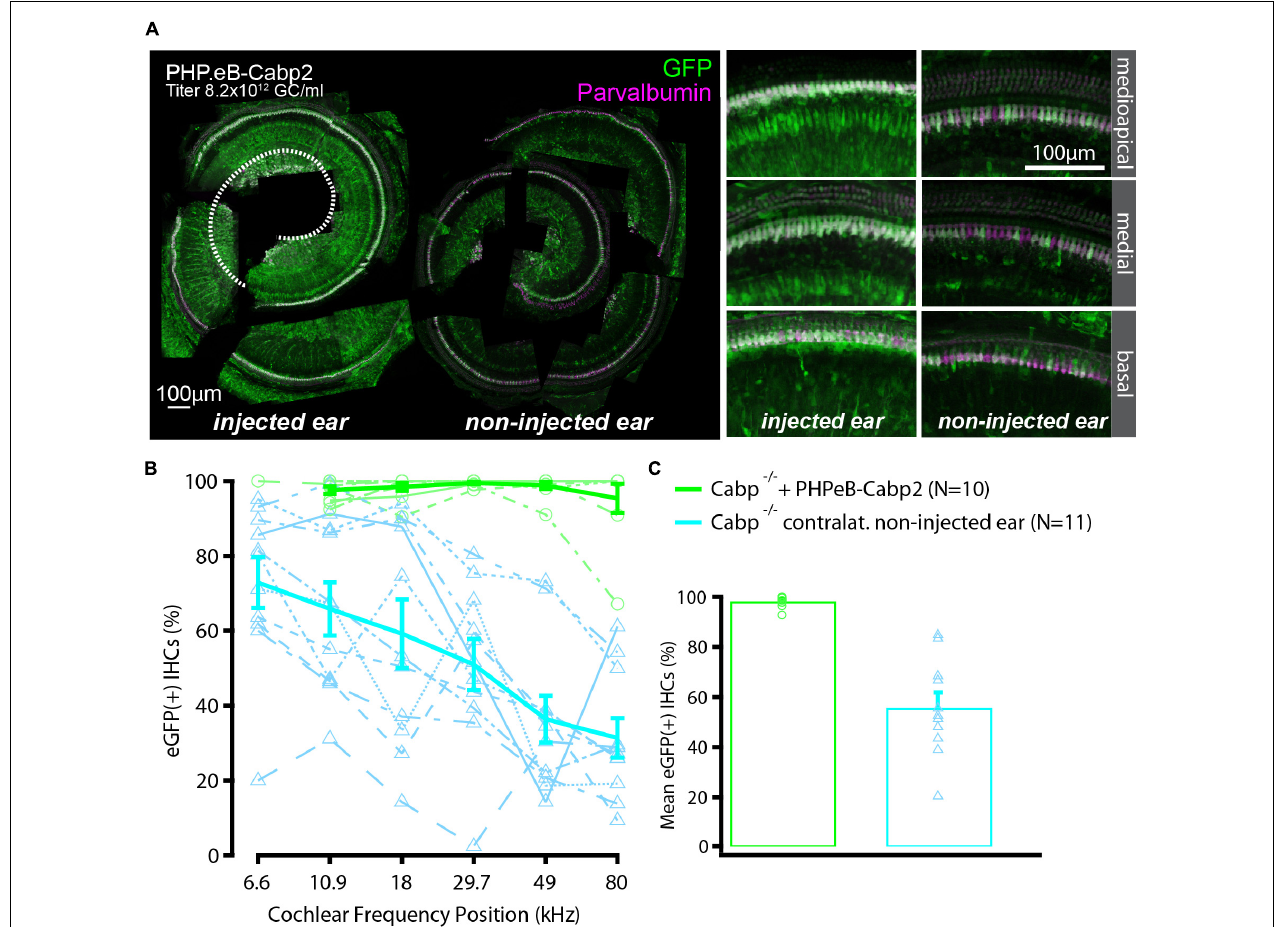
FIGURE 2 | High transduction efficiency of PHP.eB-calcium-binding protein 2 ( Cabp2 ) in Cabp2 - / - mice. (A) Examples of PHPeB- Cabp2 injected and contralateral non-injected cochleae immunolabeled for eGFP and parvalbumin alpha [note that the apical portion of the injected side (represented by white dotted line) was used for patch-clamp experiments and is thus missing in the reconstruction]. When using a PHP.eB vector, eGFP expression was also observed in the non-injected contralateral ears albeit at reduced levels. EGFP immunosignal is very strong, but not limited to IHCs (also labeled by parvalbumin alpha). (B) Based on eGFP immunofluorescence signal, the transduction efficiency in the IHCs was close to 100% over the entire length of the injected cochleae. In the contralateral ears, the transduction rates were more variable and decreased progressively from the apex toward the base. (C) Overall transduction rates were 98 ± 1% ( N = 10) for injected and 56 ± 6% ( N = 11) for non-injected cochleae. All values are given as mean ±